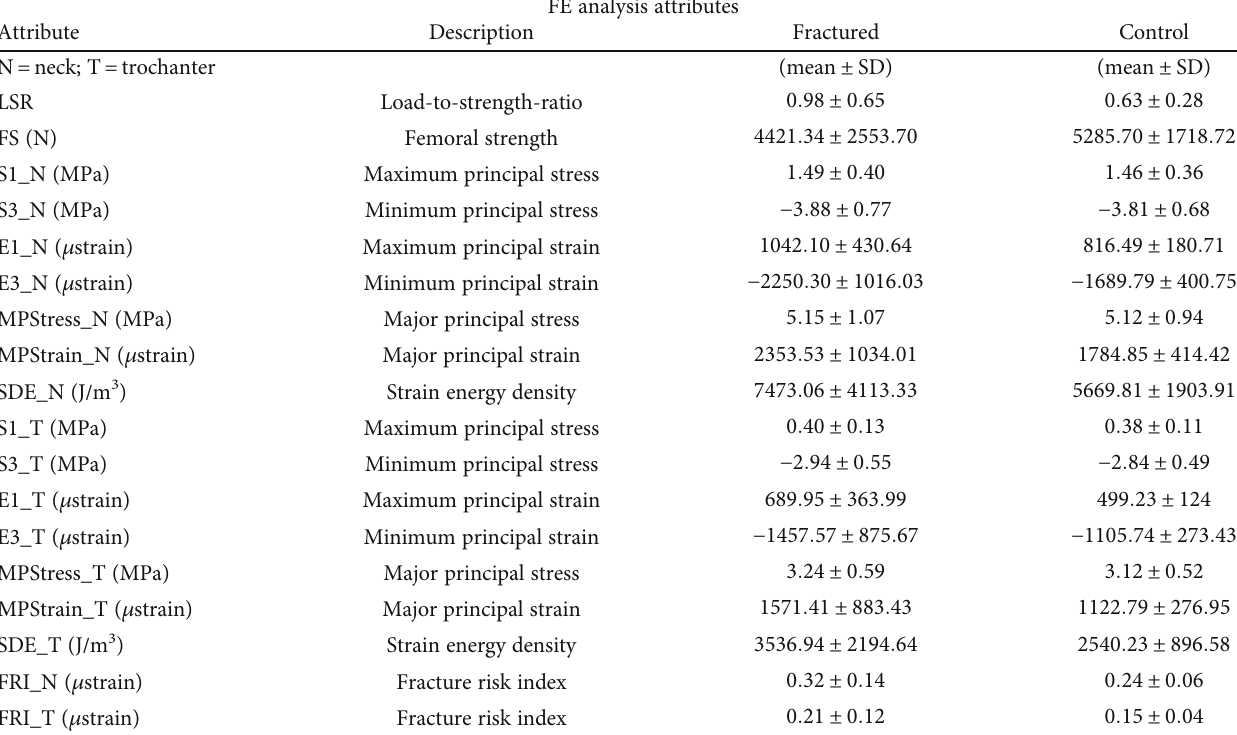
Table 5: Attributes obtained from the FE analysis of the side fall. FE analysis attributes